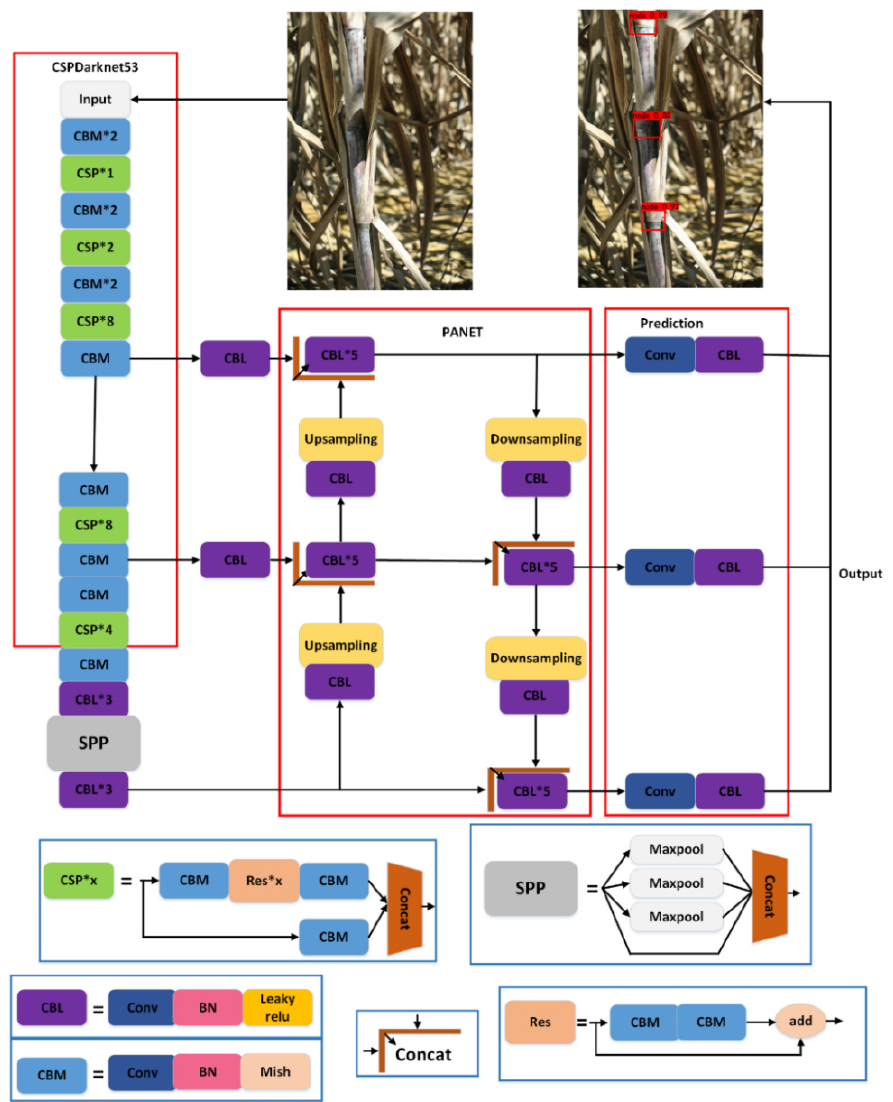
Figure 4. Detection of sugarcane stem nodes in a complex natural environment based on YOLO v4.